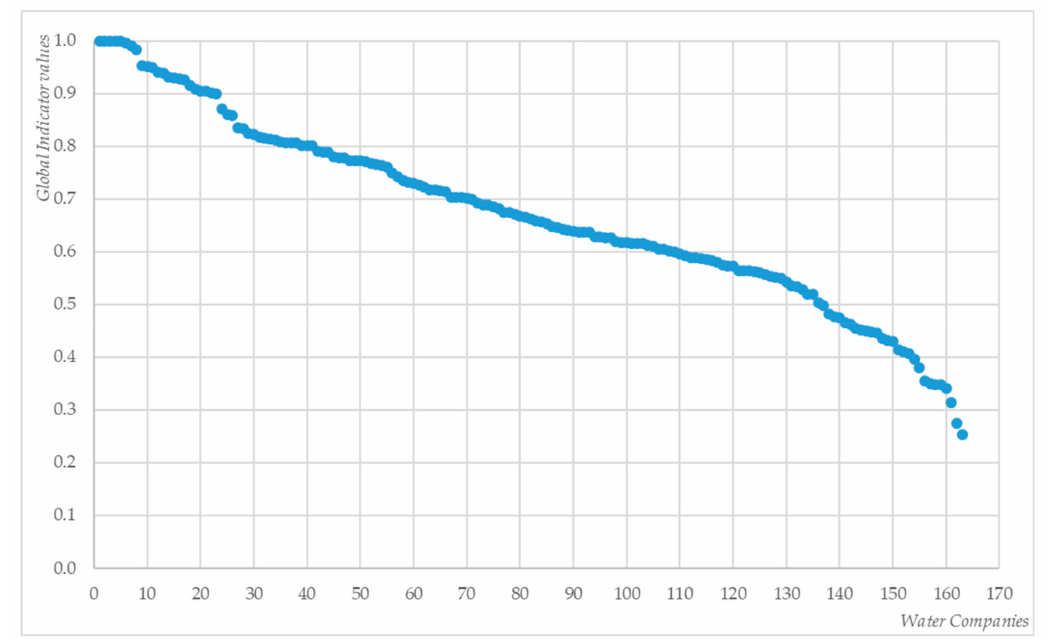
Figure 4. Global results obtained for each of the 163 water